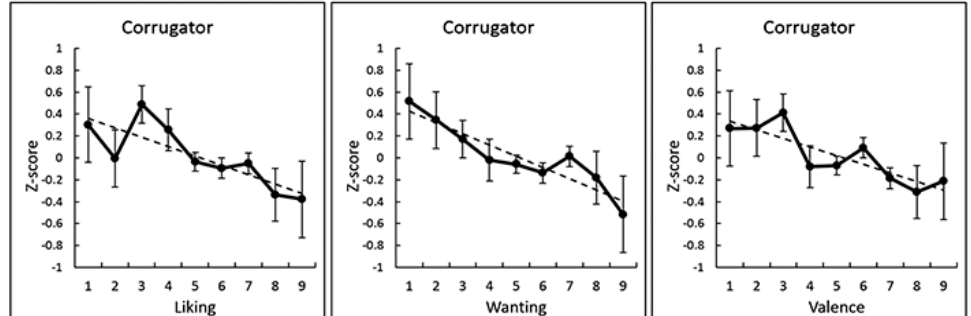
Figure 4. Group-mean (with standard error) values and regression lines of subjective ratings (liking, wanting, and valence) and corrugator supercilii electromyography activity (standardized within each individual).